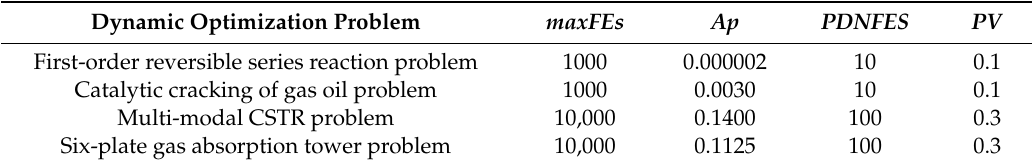
Table 6. Parameter setting values for recording the performance criterion. maxFEs: maximum number of function evaluations, Ap : acceptable precision, PDNFES : predefined number of function evaluations, PV : population flip probability factor, and CSTR: continuous stirred tank